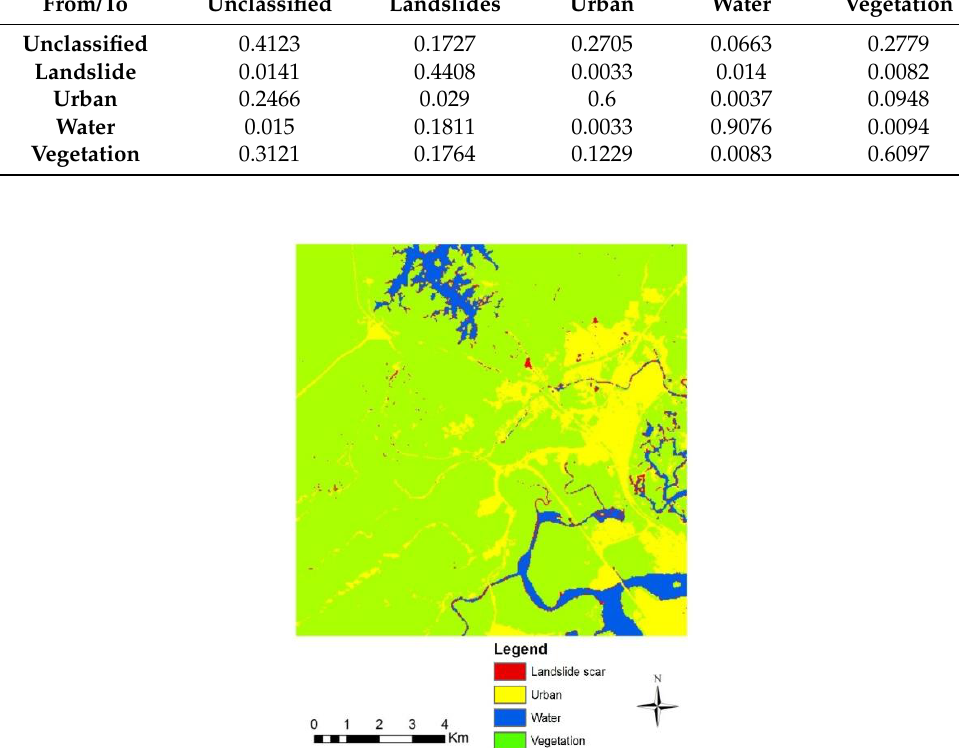
Figure 10. Final classification consisting of three algorithms (SVM, NN, and MLC) and the contextual analysis approach for tie breaking.